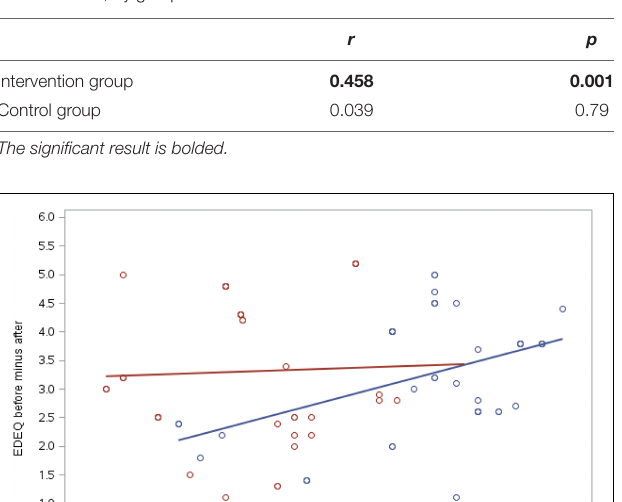
TABLE 3 | Pearson correlation between improvement in EDEQ and improvement in FRQ scores, by group.